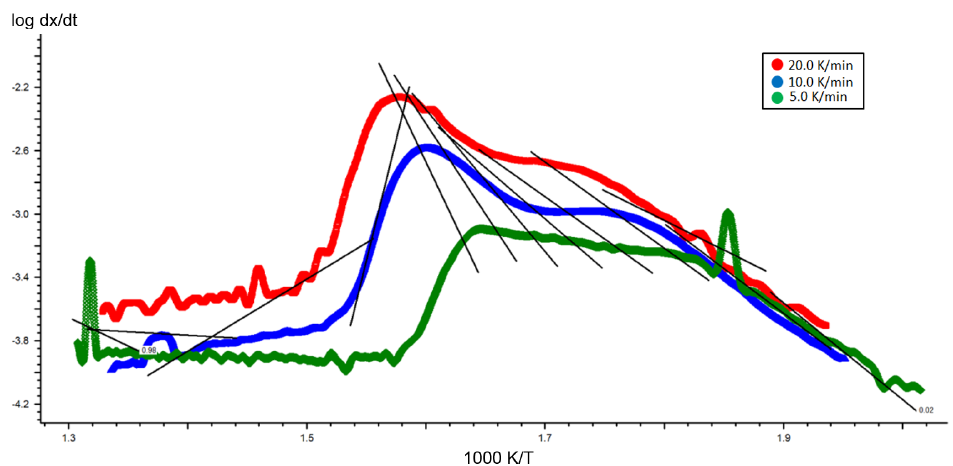
Figure A1. Log dx/dt graph as a function of temperature reverse using the Friedman method for Miscanthus.